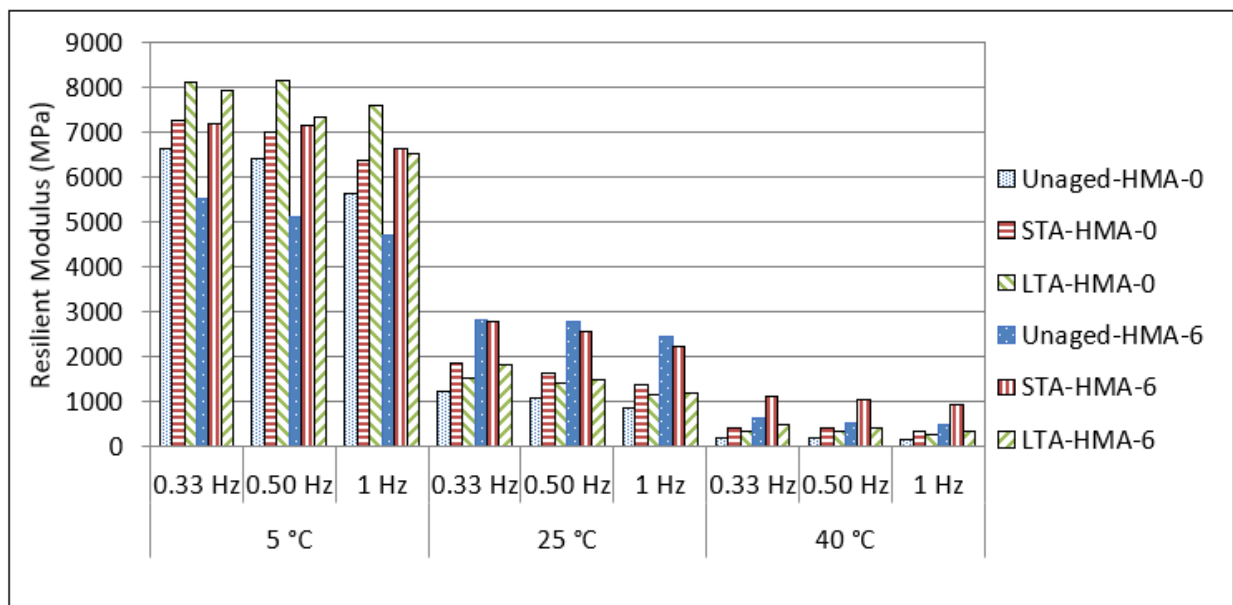
Figure 5 . Resilient modulus of unaged and aged HMA mixes. Figure 5. Resilient modulus of unaged and aged HMA mixes.